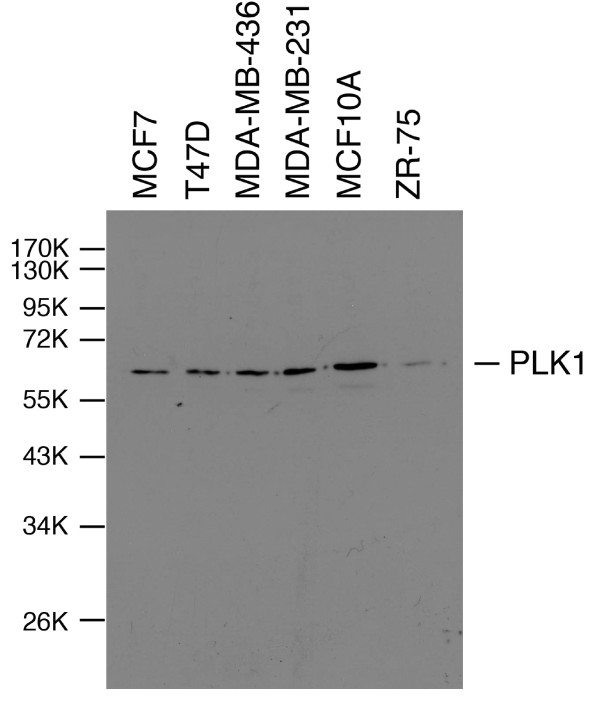
Anti-PLK1 antibody 208G4 detects only PLK1 in extracts of several breast cancer-derived cell lines. Cell extracts were prepared by lysing the cells in SDS-sample buffer and the proteins were subsequently resolved by SDS-PAGE. Western blotting analysis reveals a single band of molecular weight 62 kD corresponding to full length PLK1 in each of the cell extracts.